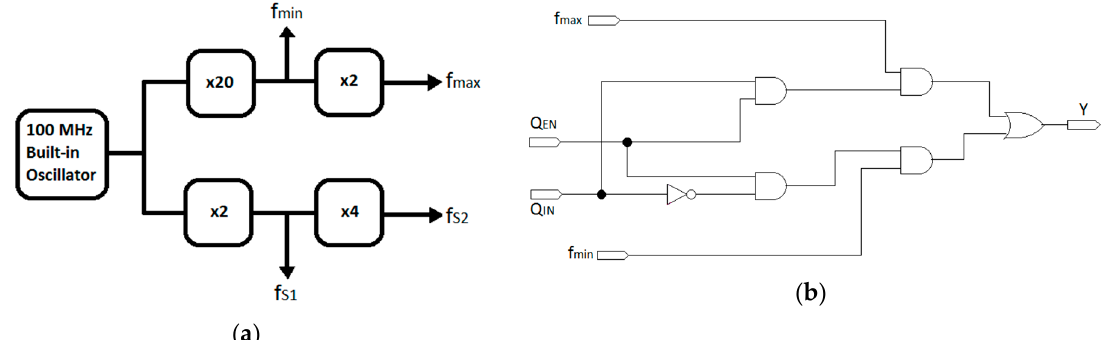
Figure 7. ( a ) Conceptual clock generating unit in the proposed TDC; ( b ) schematic of GSRO operating frequency control unit.